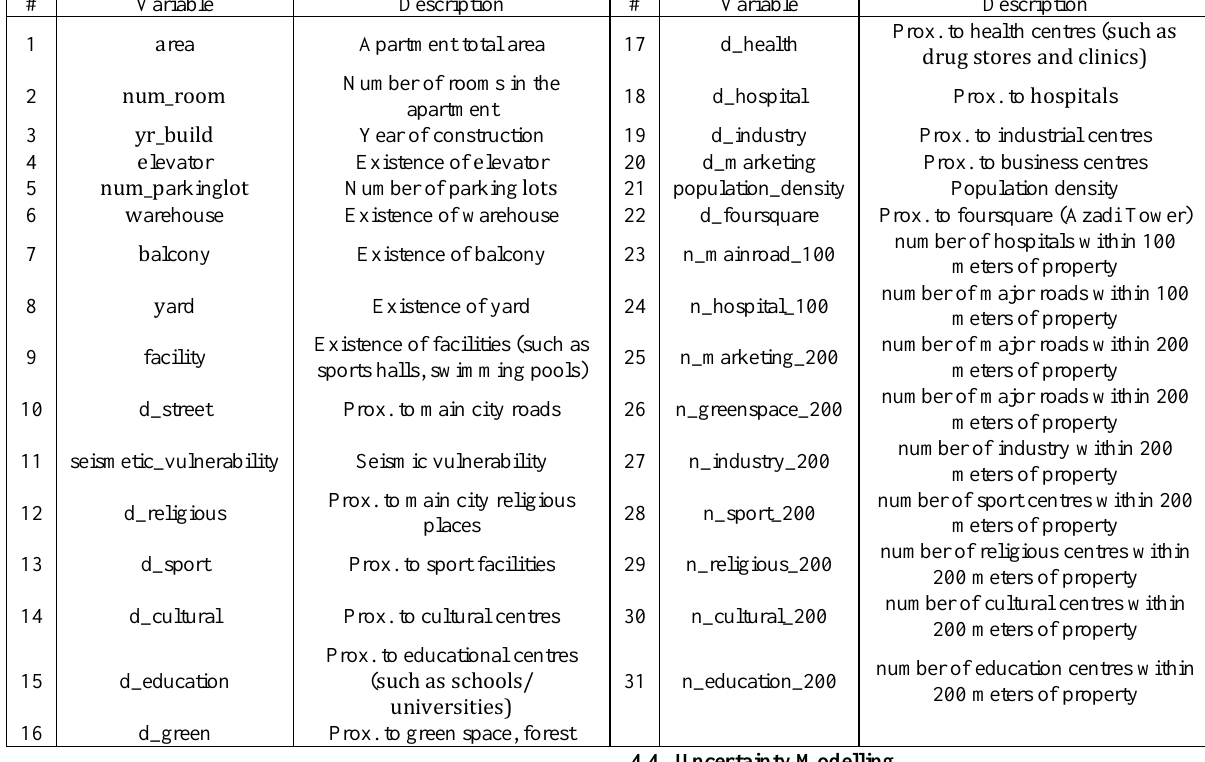
Table 1. Descriptive variables of residential properties